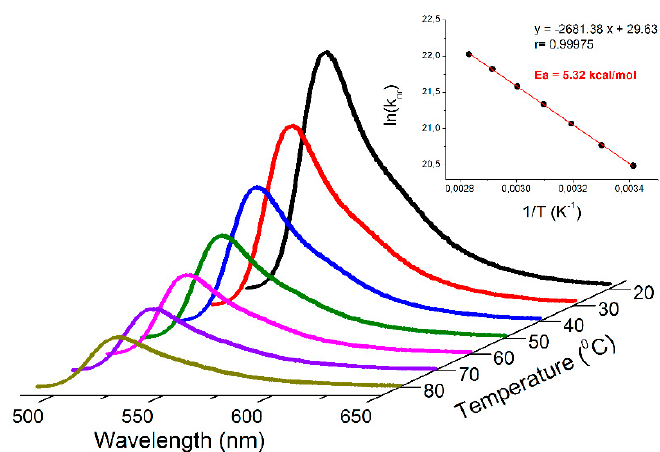
Figure 6. Evolution of the fluorescence spectra of dyad 6 with the temperature in ethylene glycol. The corresponding Arrhenius plot for the non-radiative rate (k nr ) constant is also enclosed. The k nr data at each temperature was calculated after checking that the absorption spectra are the same regardless of the temperature, and assuming that the radiative rate constant (k fl ) does not change with the temperature. In other words, the loss of fluorescence signal upon heating is due solely to an increase of the internal conversion related to the 8-aryl motion.